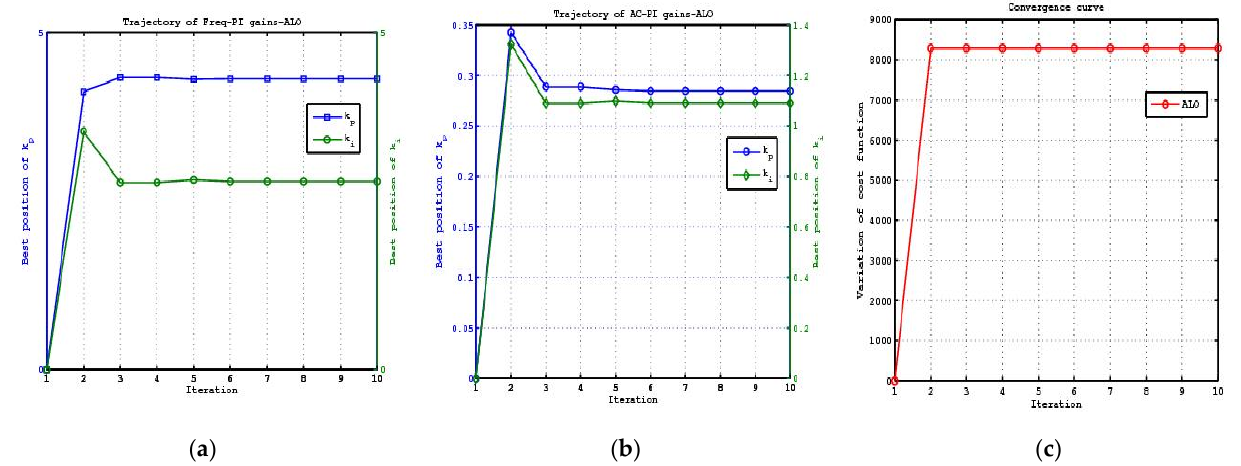
Figure 4. ( a ) Trajectory of frequency PI gain; ( b ) Trajectory of AC PI gain; ( c ) Convergence curve using Antlion algo- rithm(ALO).